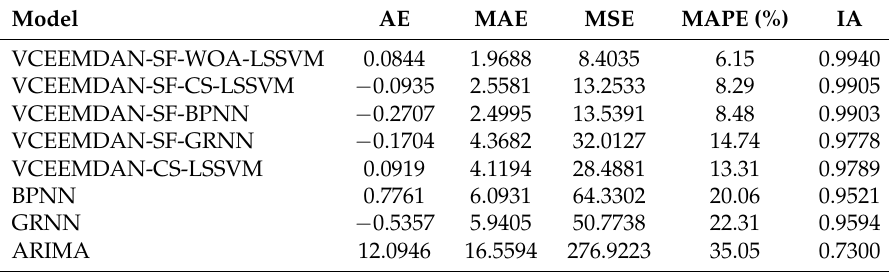
Table 7. Experiment II forecasting results in Yibin.